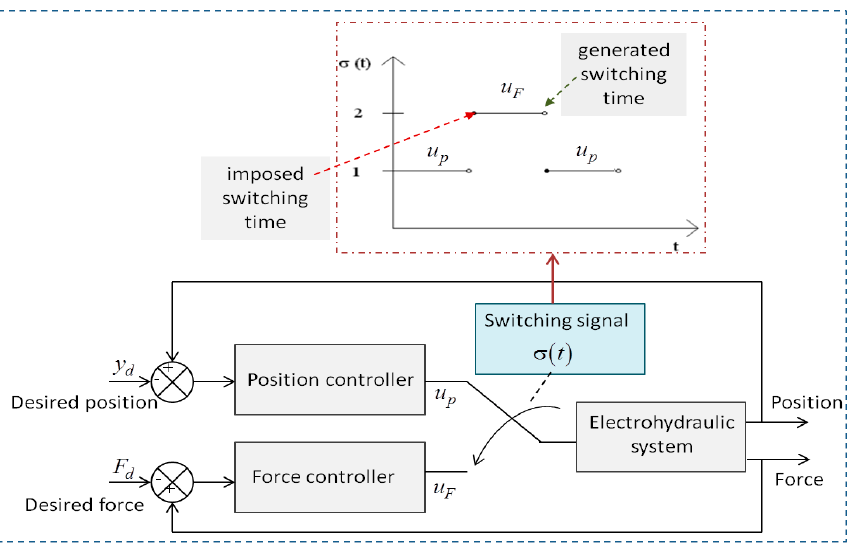
Figure 2. Principles of the hybrid controller.